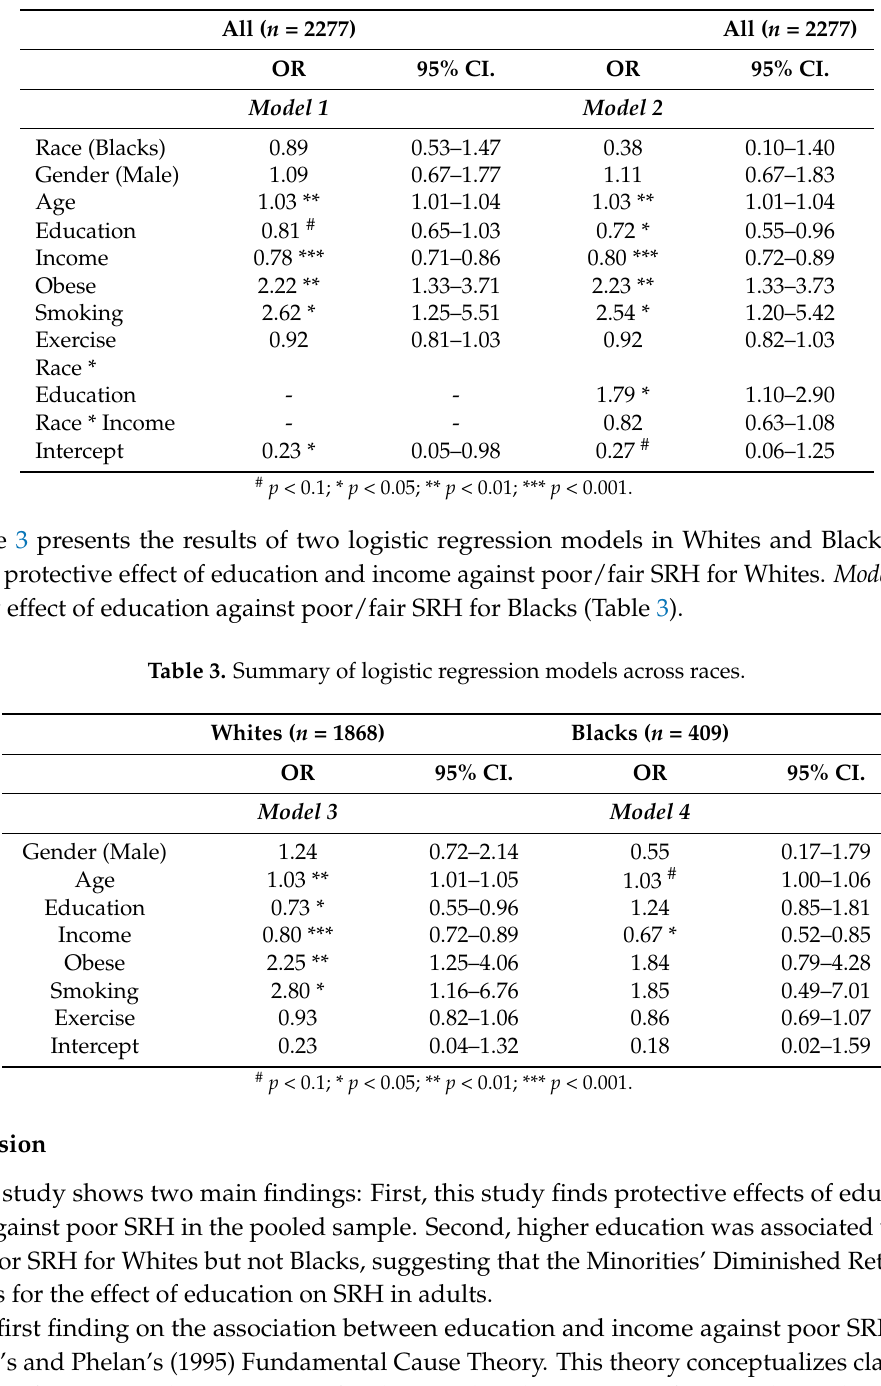
Table 2. Summary of logistic regression models in the overall sample.